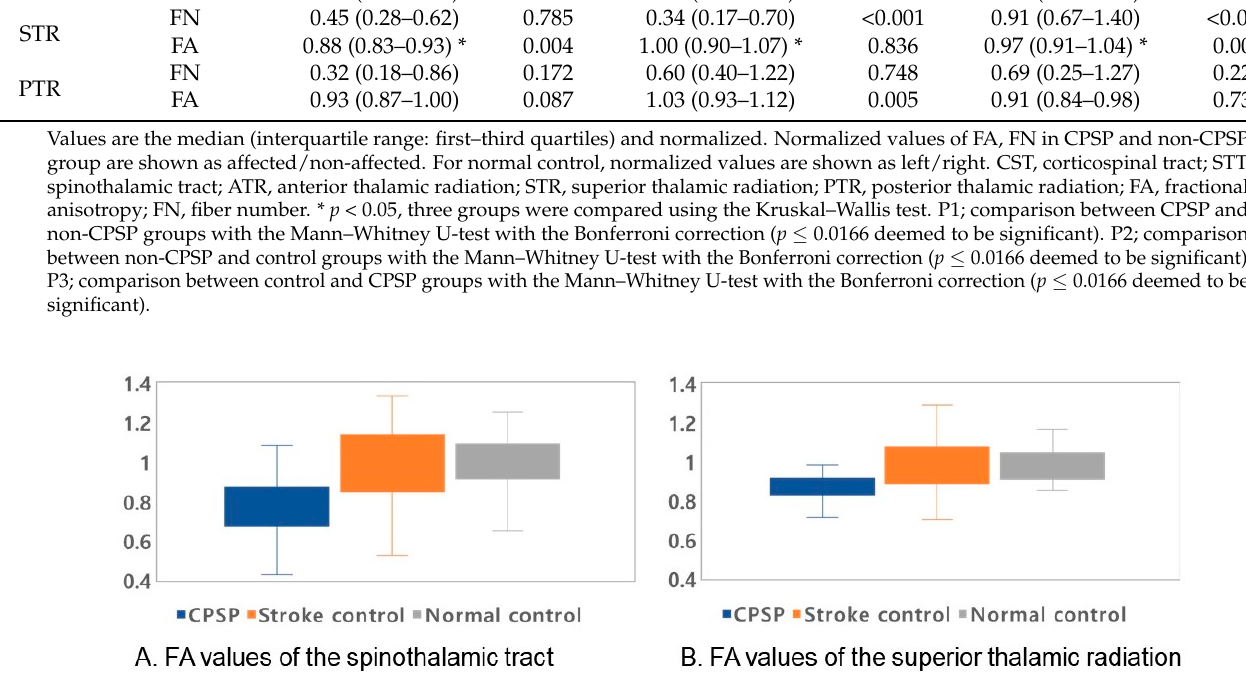
Figure 2. Normalized fractional anisotropy (FA) values of the spinothalamic tract (STT) and superior thalamic radiation (STR). The median values with quartiles are shown as lines. For all values, the rectangular shape shows the range between the first and third quartiles. ( A ) FA values for STT for all groups. The FA value of STT in the CPSP group was lower than those in the stroke control and normal control groups ( p -value < 0.001). ( B ) FA values for STR for all groups. The FA value of STR in the CPSP group was lower than those in the stroke control and normal control groups ( p -values 0.03, and 0.01, respectively).